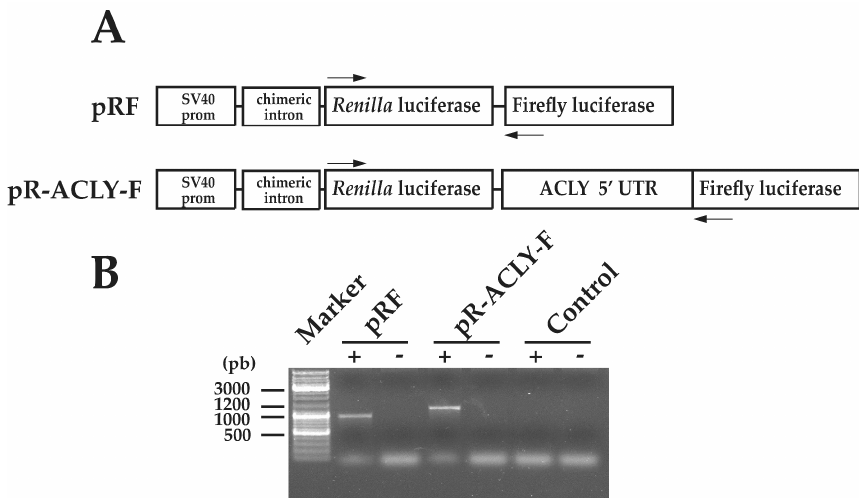
Figure 4. Cryptic splicing does not occur in the dicistronic transcript containing ACLY 5 ′ UTR. ( A ) Dicistronic constructs used to transfect HepG2 cells are depicted. The arrows indicate the positions of the primers CSFor and CSRev used for RT-PCR and reported in Table 1. RT-PCR analysis was performed as additional test to rule out cryptic splicing within the ACLY 5 (cid:48) UTR in the intercistronic region. ( B ) RNA was extracted by HepG2 cells transfected with the dicistronic constructs and used as a template for RT-PCR. The amplimers containing the RL and the intercistronic region were analyzed on ethidium-bromide-stained agarose gel. The result is from a representative experiment ( n =